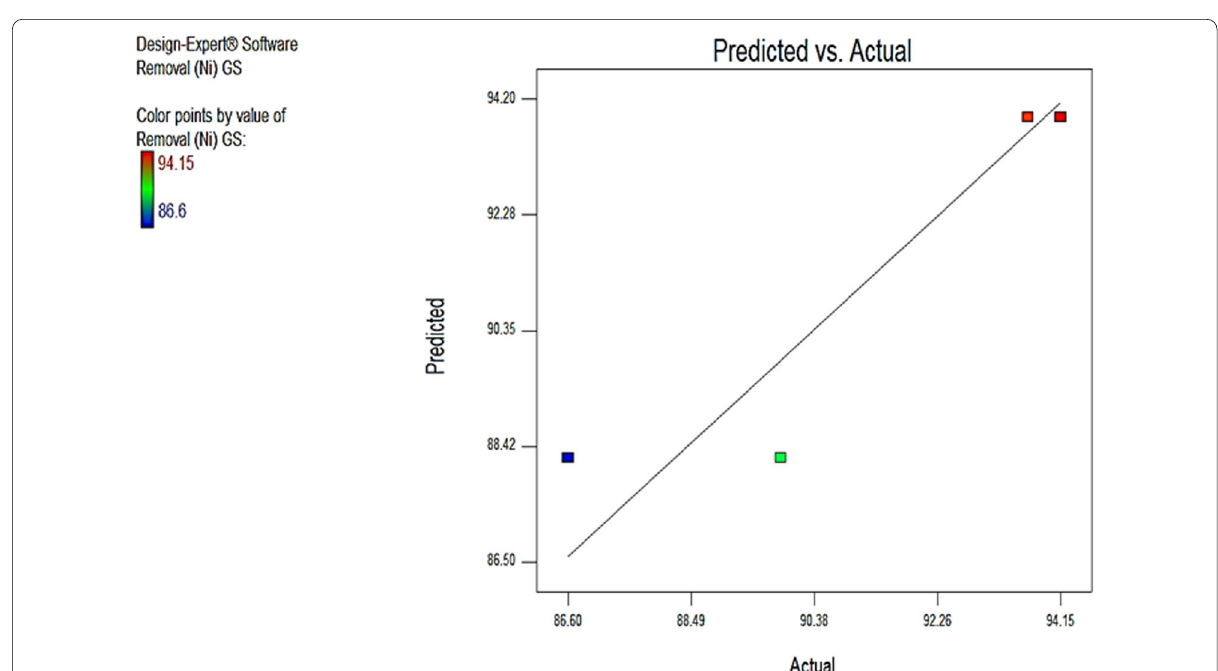
Fig. 11 A cross-validation plot predicted response against actual values of response from selected factorial model on the removal of Nickel when groundnut shell residues are used as